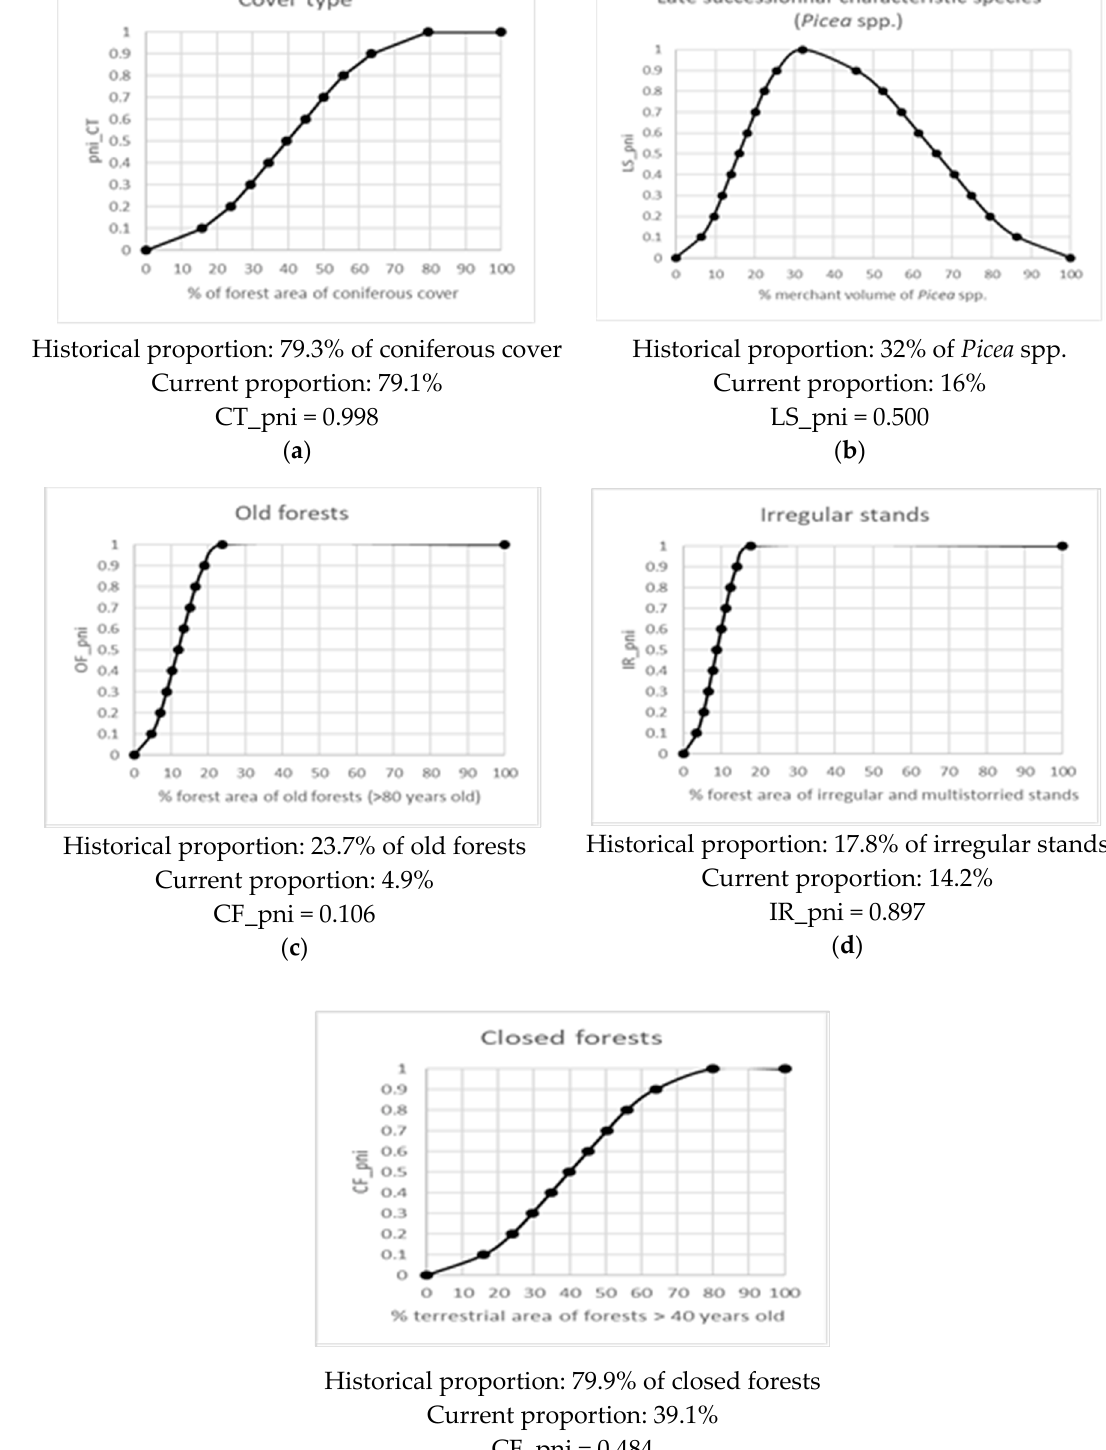
Historical proportion: 85.7% of coniferous cover Current proportion: 81.9% CT_pni = 1 ( a ) Historical proportion: 39% of Picea spp. Current proportion: 16% LS_pni = 0.362 ( b )